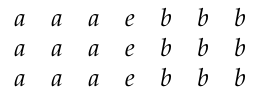
Figure 2. A picture array generated by Π 1